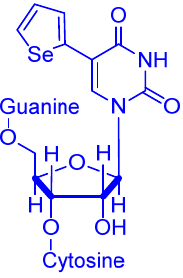
Figure 1. Uracil derivatization with selenophene by Nuthanakanti et al. There have been many important and pertinent Se–related review articles produced.